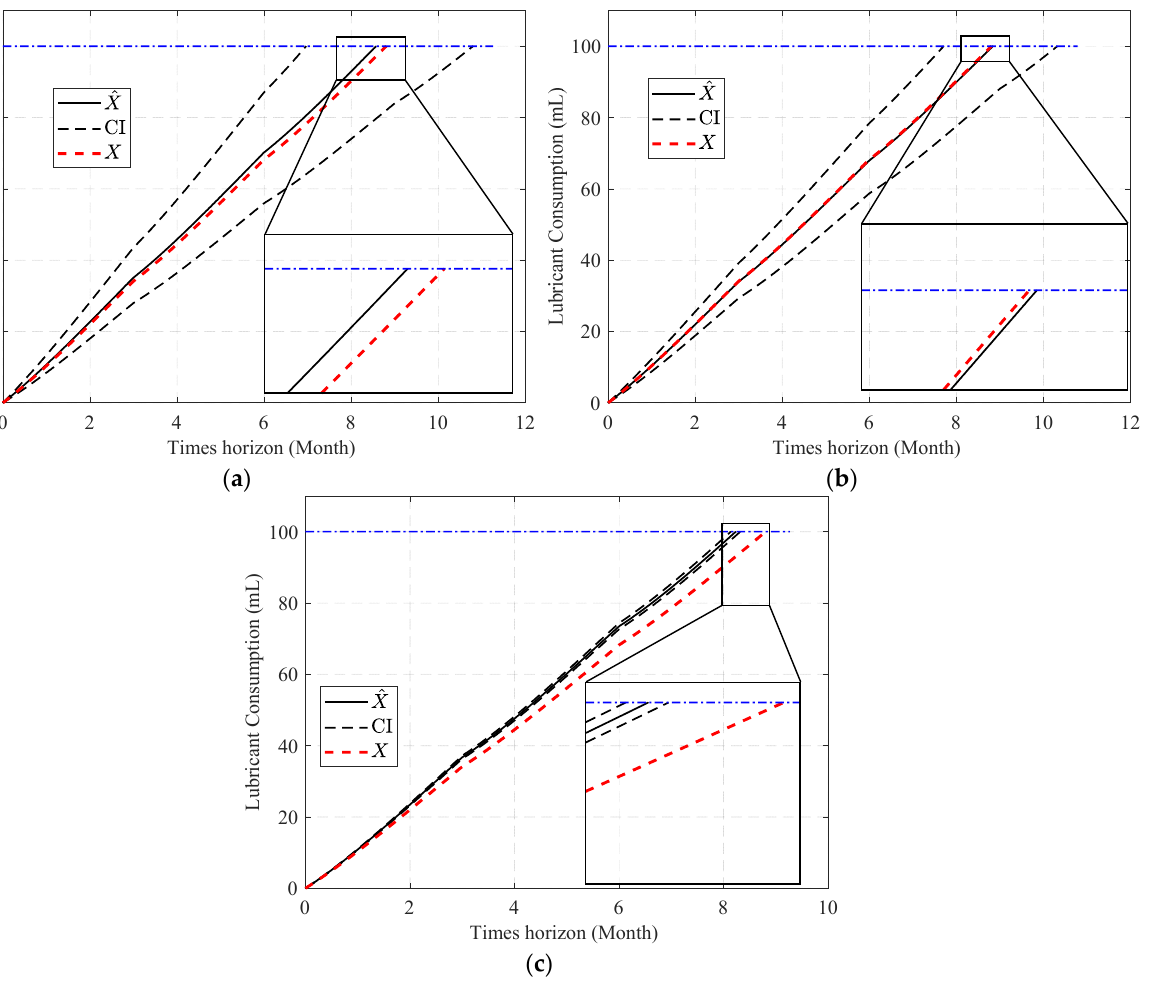
Figure 19. Failure prognosis results (first fault scenario): ( a ) using PF for temperature estimation and the two-step method for parameter estimation; ( b ) using APF for temperature estimation and the two-step method for parameter estimation; and ( c ) using APF for temperature estimation and the one-step method for parameter estimation.